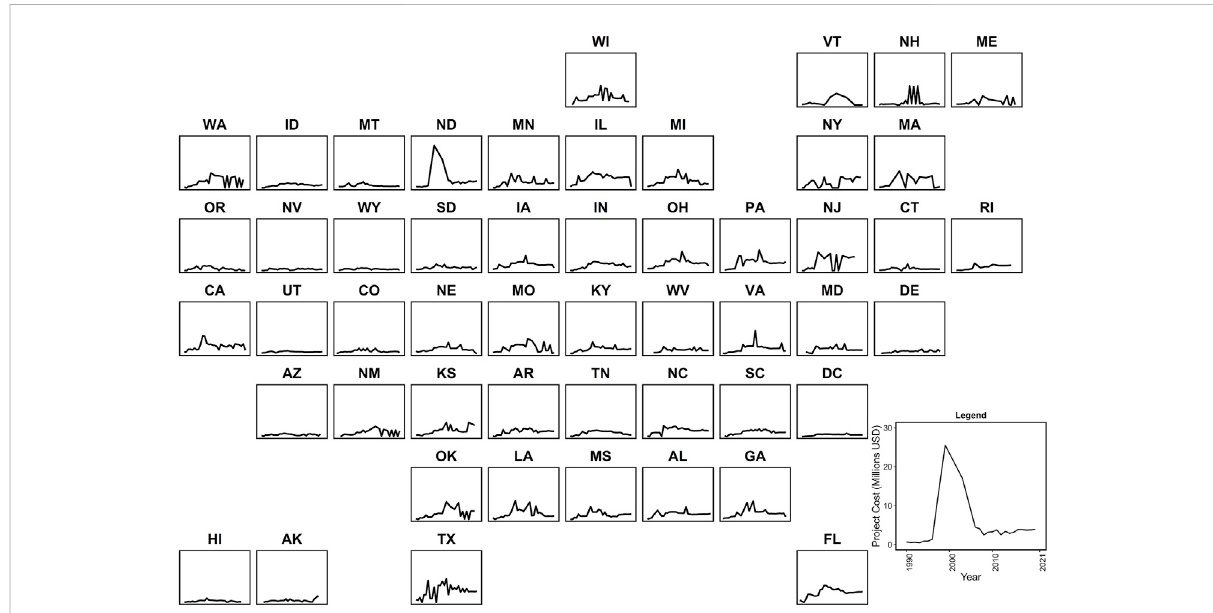
FIGURE 5 Changesinthespatial distributionofspendingintheUSEPA319programamongstatesovertime.Theinsetlegend(bottomright)describesthe axes used for all state plots, and uses data from the state of North Dakota (ND) as an example. State abbreviations follow ANSI two-letter codes and are arranged in each state ’ s approximate geographic